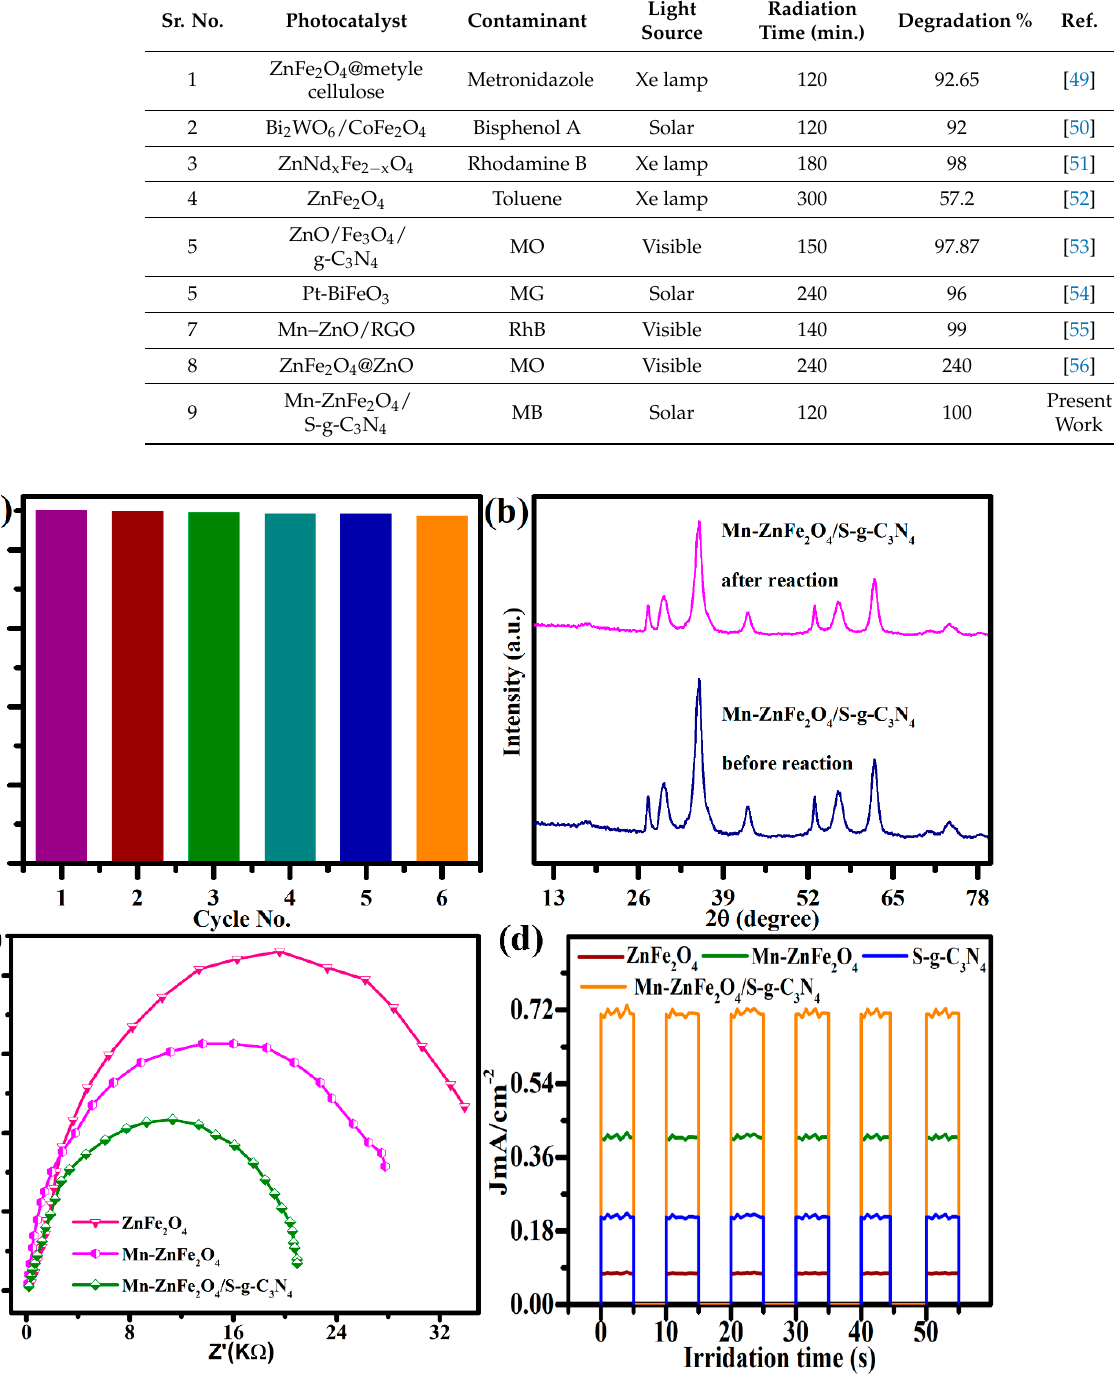
Figure 6. ( a ) Cyclic stability of the Mn-ZnFe 2 O 4 /50% S-g-C 3 N 4 NCs through the sixth cycle. ( b ) The structural stability of Mn-ZnFe 2 O 4 /50% S-g-C 3 N 4 NCs was determined by comparing XRD patterns obtained before the first cycle and after the sixth recycling experiment. ( c ) EIS Nyquist plots of ZnFe 2 O 4 , Mn-ZnFe 2 O 4, and Mn-ZnFe 2 O 4 /50% S-g-C 3 N 4 NCs and ( d ) transient photocurrent responses of ZnFe 2 O 4 , S-g-C 3 N 4 , Mn-ZnFe 2 O 4, and Mn-ZnFe 2 O 4 /50% S-g-C 3 N 4 NCs in visible-light irradiation.